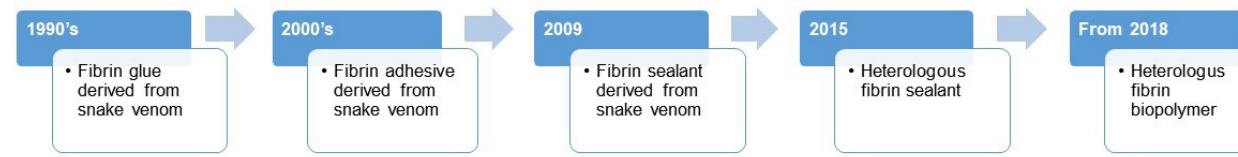
Figure 2. Evolution of the terminology of the heterologous fibrin biopolymer